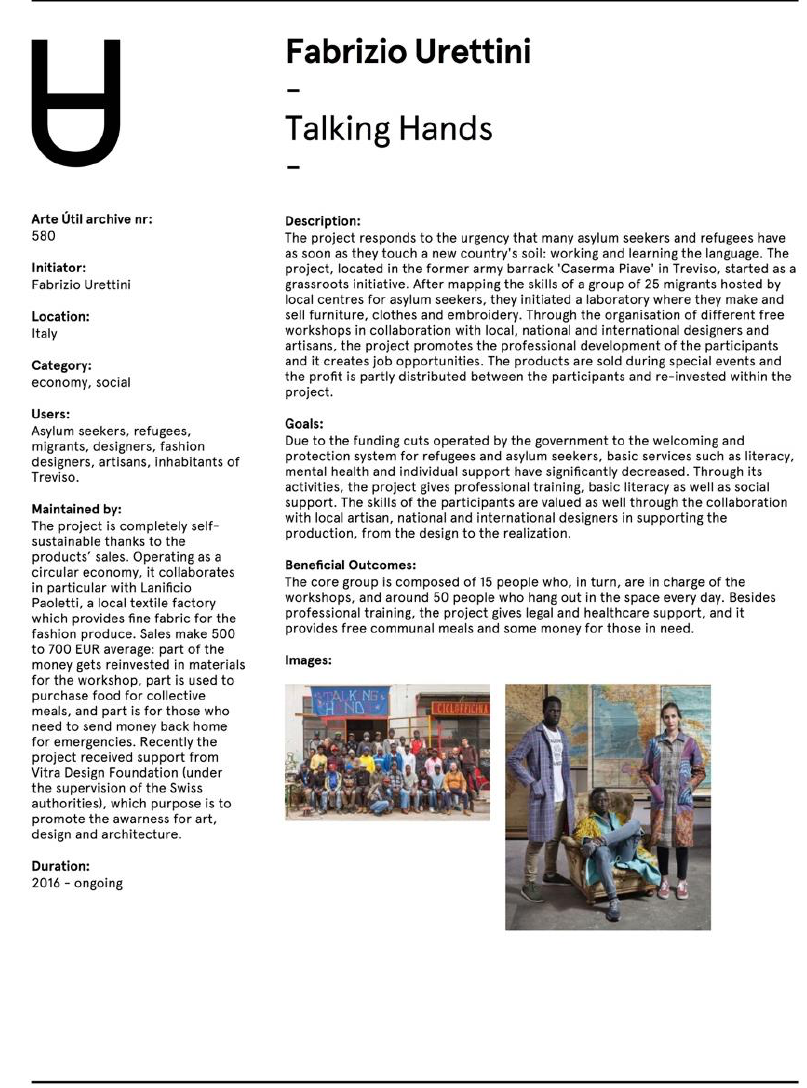
Figure 1. Each case study included in the Arte Ú til archive is recorded through a form that generates pdfs that are free to download from the website